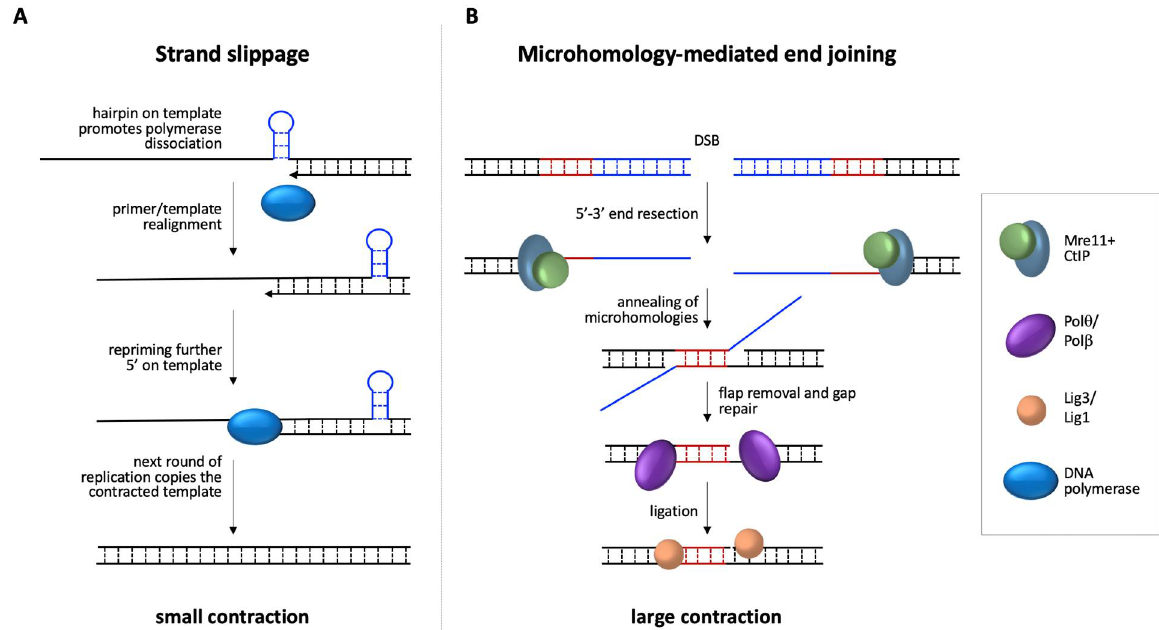
Figure 3. Diagrammatic representation of potential contraction/deletion pathways. ( A ) Strand-slippage during replication may be exacerbated by hairpins formed on the template strand. Repriming more 5′ on the template would lead to nascent strands with fewer repeats than the template strand. A subsequent round of replication would generate a contracted allele. ( B ) MMEJ-mediated repair of a DSB is initiated by end-resection to reveal MHs at either side of the break. Annealing of these MHs is followed by removal of non-homologous flaps, filling of any gaps, perhaps by Polθ or Polβ, and ligation by either ligase 3 (Lig3) or ligase 1 (Lig1).